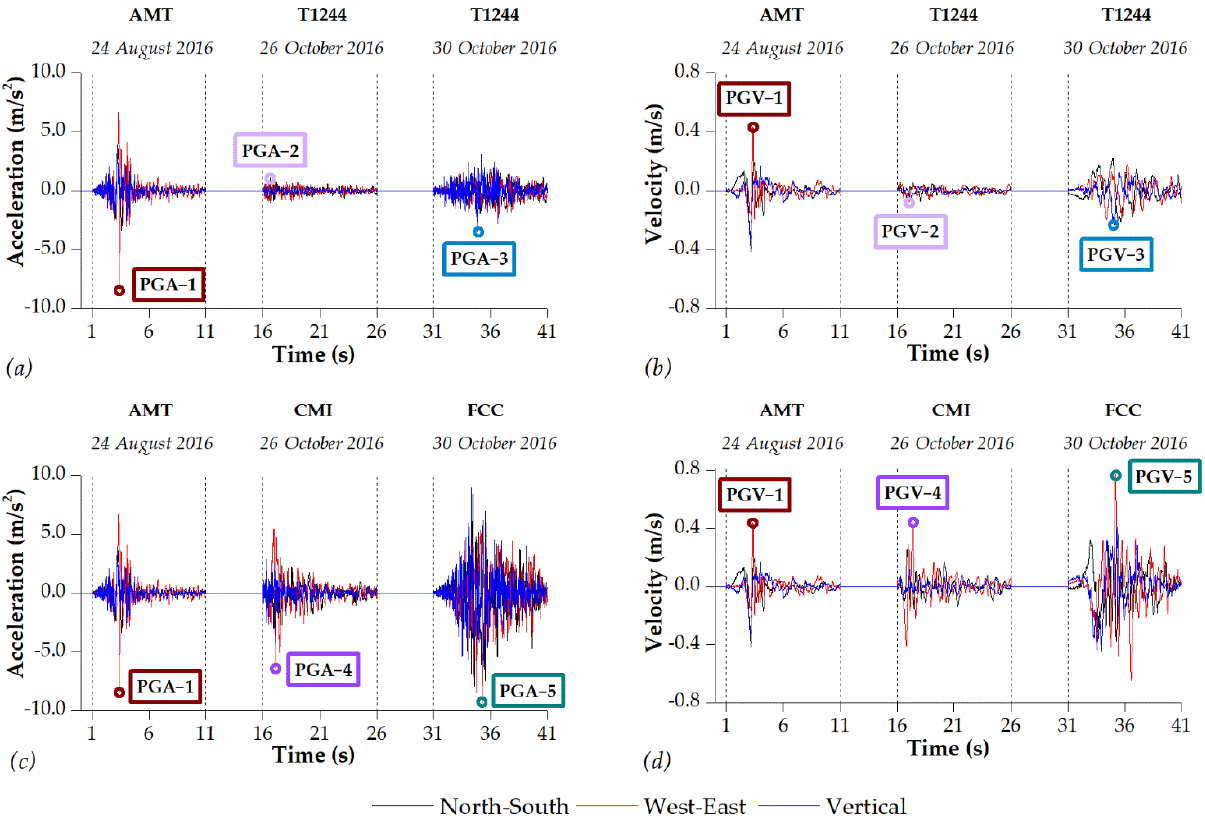
Figure 9. Accelerations and velocities used in the nonlinear dynamic analyses of the church and recorded respectively ( a , b ) near Pretare and ( c , d ) in the earthquake epicenters.